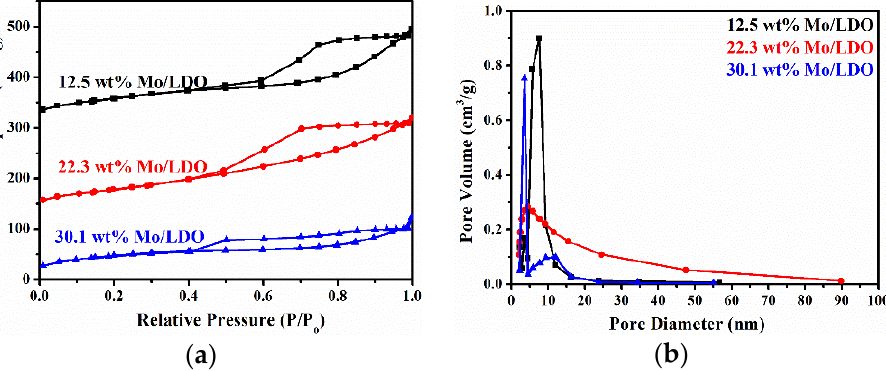
Figure 2. ( a ) N 2 adsorption − desorption isotherms and ( b ) the corresponding pore size distribution of the as-prepared Mo/LDO catalysts.